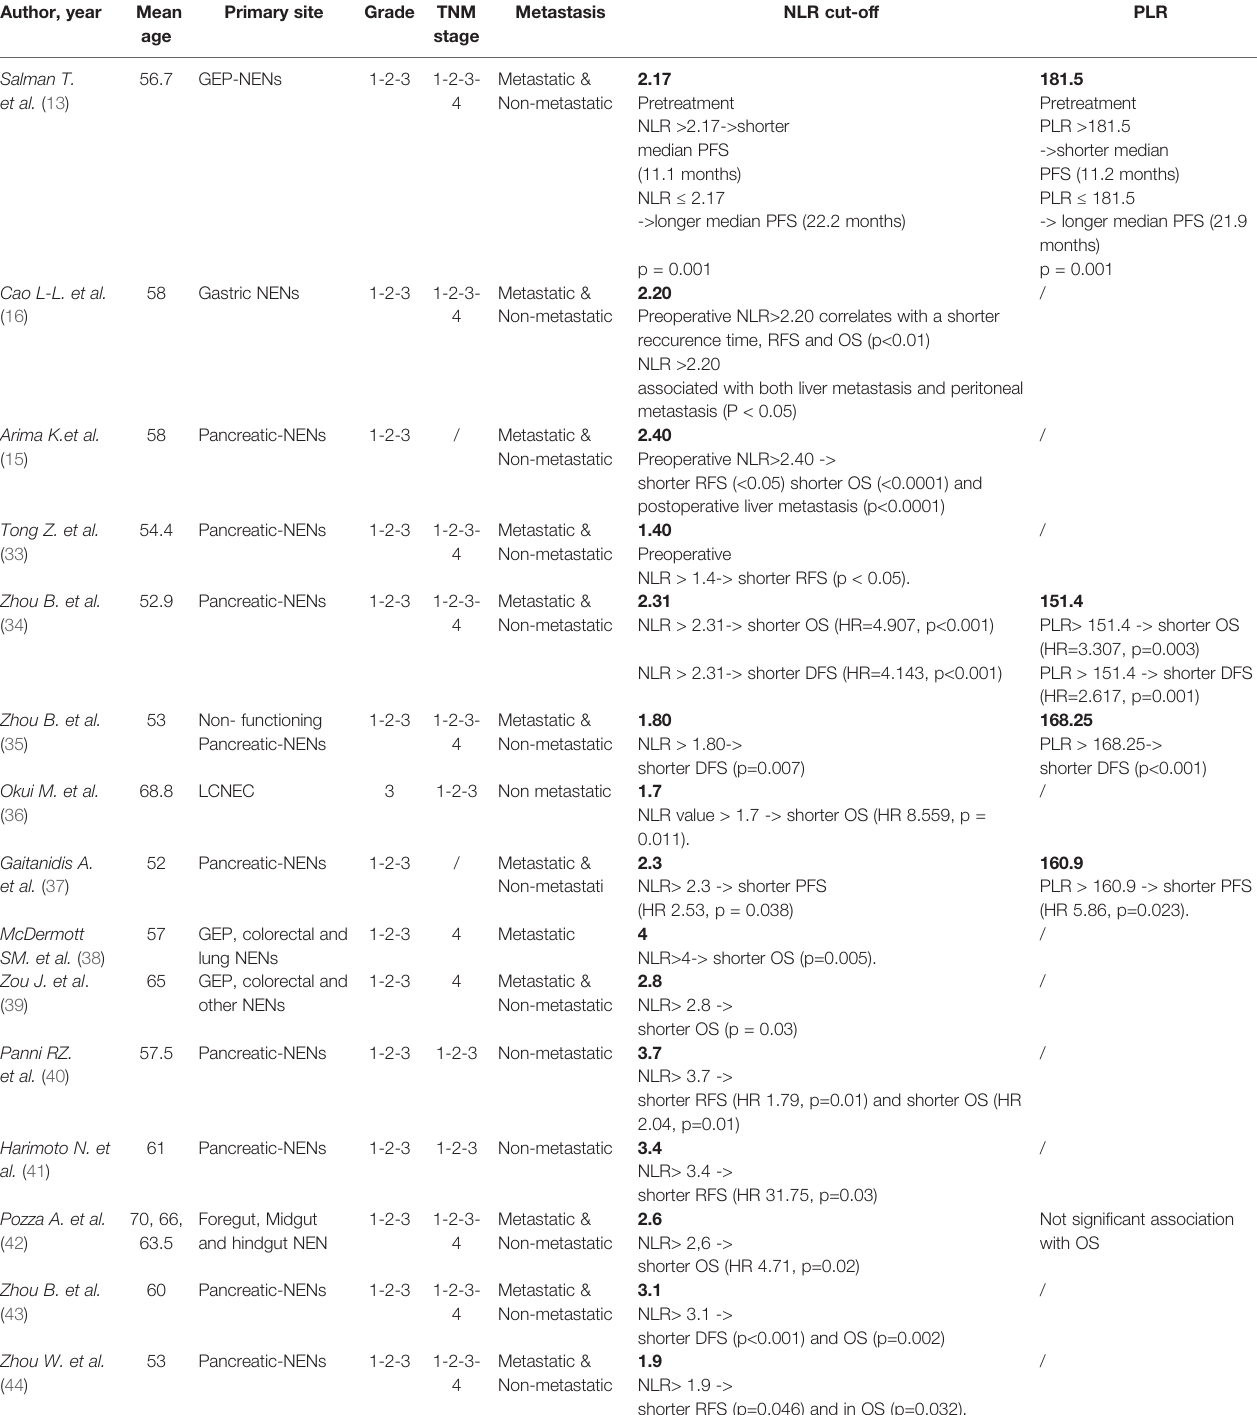
TABLE 1 | Prognostic values of Neutrophil-Lymphocyte Ratio (NLR) and Platelet-to-Lymphocyte Ratio (PLR) in NENs patients. Author,